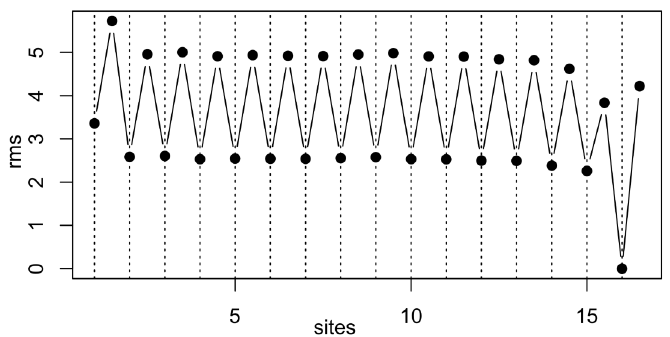
Figure 7 . Contributions to Im( S ) for the contour corresponding to the ansatz with special point. The values near the special point (from about 14 . 5 and up to 1 . 5 ) differ significantly from those of figure 5.